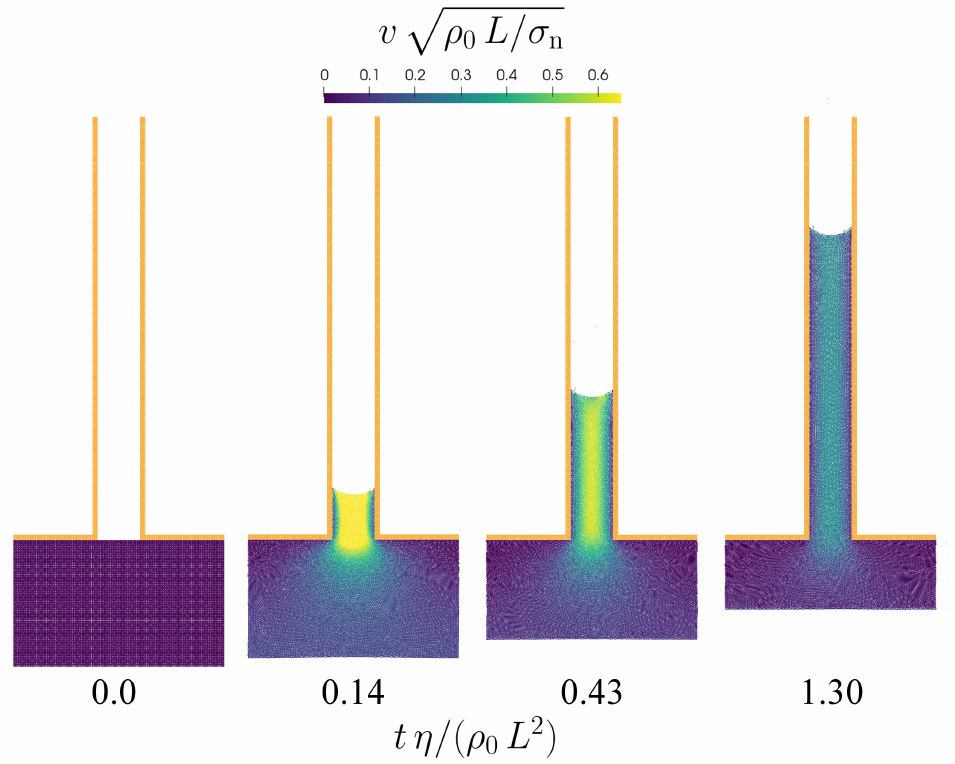
Figure 16. Flow from a reservoir into a nozzle formed by parallel plates. The normalized velocity magnitude is color-coded. The time is normalized using a Reynolds